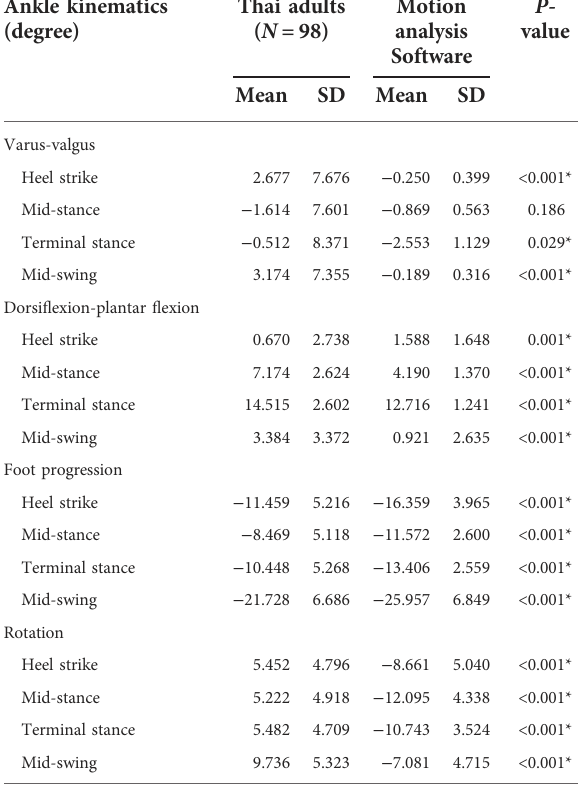
+=ankle varus, dorsi fl exion, internal foot progression and internal rotation, − =ankle valgus, plantar fl exion, external foot progression and external rotation. *Signi fi cant P